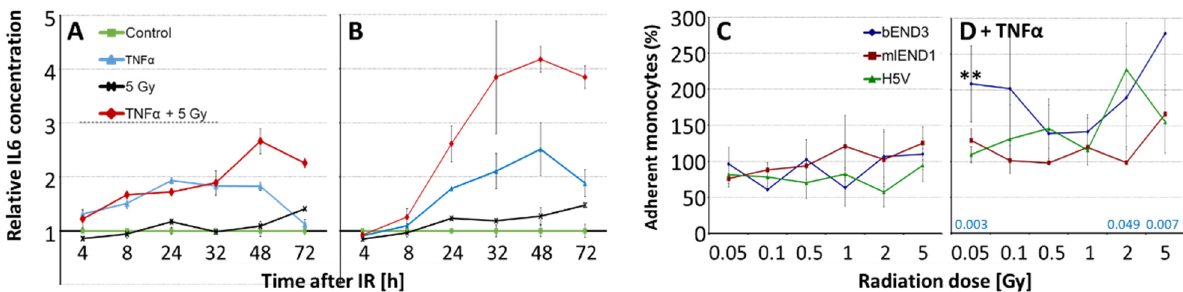
Figure 4. Time dependent analysis of IL6 release in mlEnd1 cells after 16 h-prestimulation ( A ) and after costimulation ( B ) with TNF α . Relative IL6 values are presented (mean of duplicates ± SEM, n = 1) versus untreated control (=1). Relative adhesion values of monocytes (WEHI-274.1) on H5V, mlEND1, bEND3 ECs in ( C ) nonstimulated (0 Gy control = 100%) and in ( D ) TNF α costimulated cells, (TNF α -treated 0 Gy control = 100%), n = 3. Asterisks shows significant enhancement vs. control in the bEND3 cell line (**, p ≤ 0.01). p -values of combined analysis of all three cell lines are shown in blue.